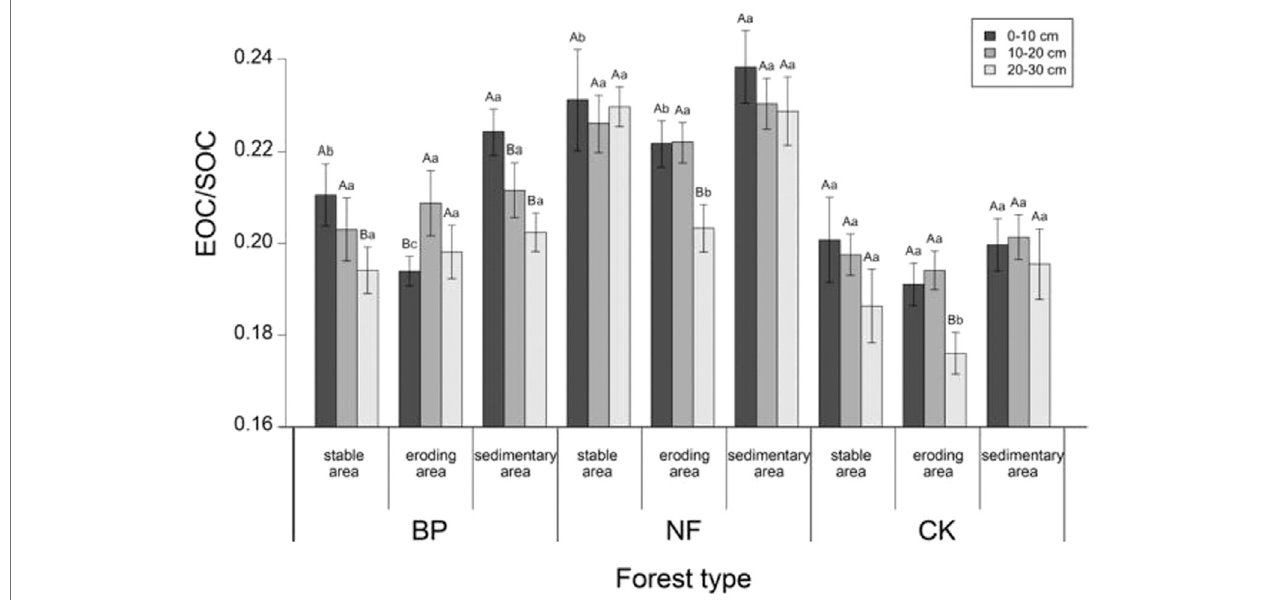
FIGURE5| Ratioofeasilyoxidizedorganiccarbon(EOC)toSOCofthe0 – 30 cmsoillayer(in10 cmintervals)inthethreeareasunderdifferentforesttypes.Vertical bars represent the standard deviations of fi ve replicated soil samples. Different capital letters for the same areas indicate signi fi cant difference at p < 0.05 of soil layers, while different lowercase letters of the same soil layers indicate signi fi cant differences at p < 0.05 of different regions.